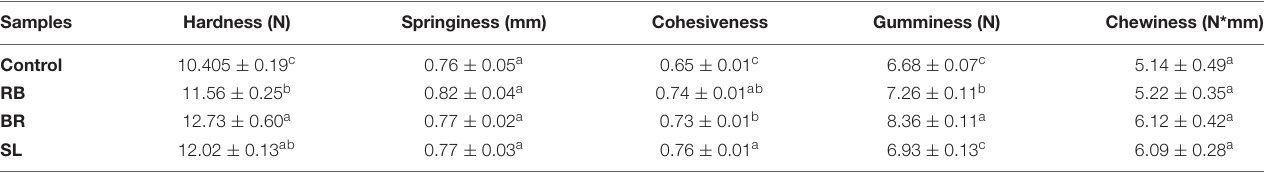
TABLE 2 | Chemical analysis of UF cheese with the RB, BR, and SL complex coacervates. Parameter s